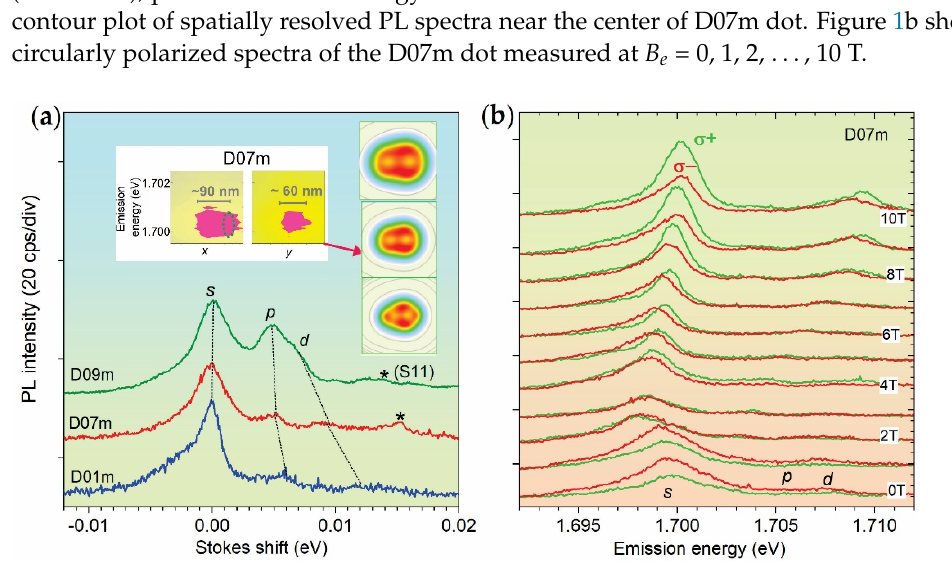
Figure 1. ( a ) Comparison of low-temperature (10 K) PL spectra of D01m, D07m and D09m InP/GaInP 2 QDs. Lines connect the peak maxima and stars denote neighboring dots. Center inserts show portions of contour plots of a set of spatially resolved near-field PL spectra of D07m measured along two perpendicular directions, in which regions corresponding to the size of emission area are outlined by the magenta color and the horizontal bars. The dashed ellipse in x -scan outlines contribution of neighboring dot. Right inserts show charge density distributions (size 100 × 100 nm) of the dots (upper D09m, lower D01m) calculated using the CI method. ( b ) Circular polarized spectra of D07m measured in the range B e = 0–10